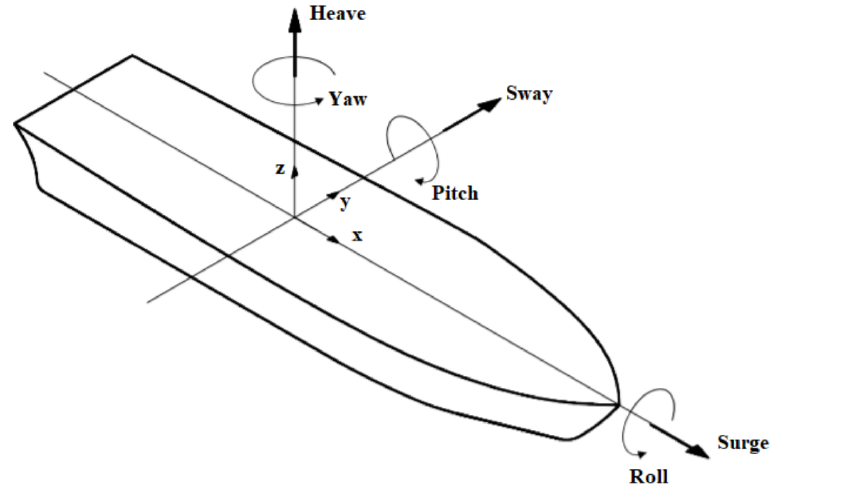
Figure 1. Ship’s six degrees of motion due to external